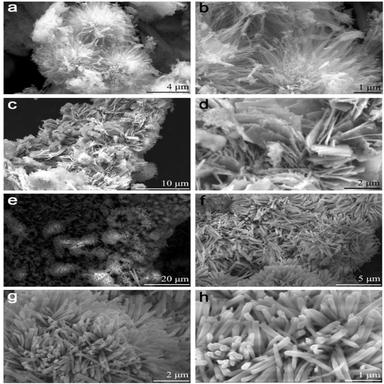
SEM images of CuCo2S4 (a, b); CoMoO4 (c, d); and CuCo2S4@CoMoO4 nanorod structures (eeh).